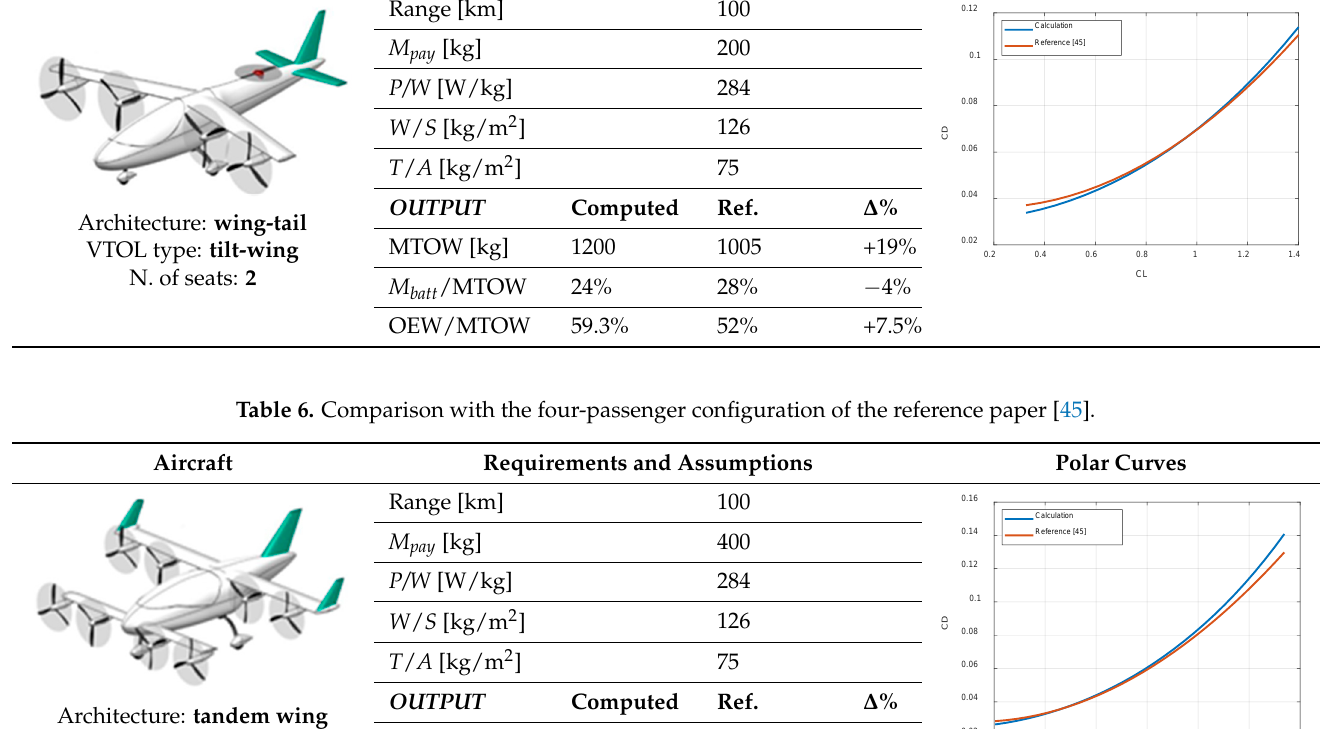
Table 5. Comparison with the two-passenger configuration of the reference paper [45].